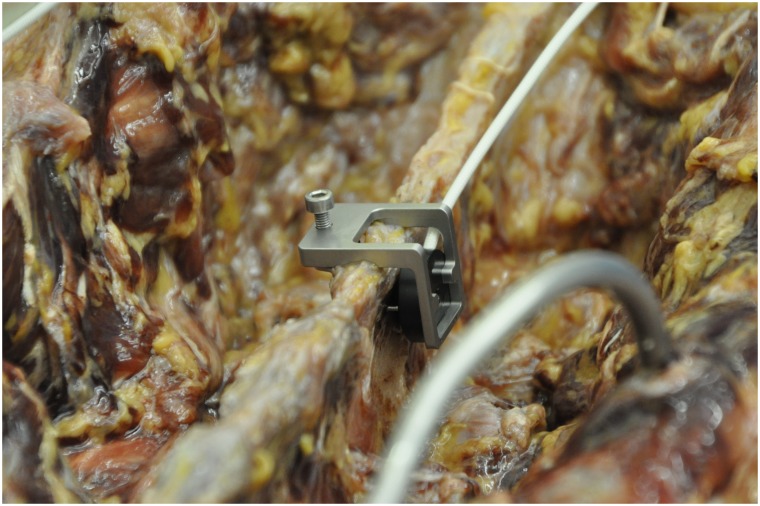
Patient Tracker.